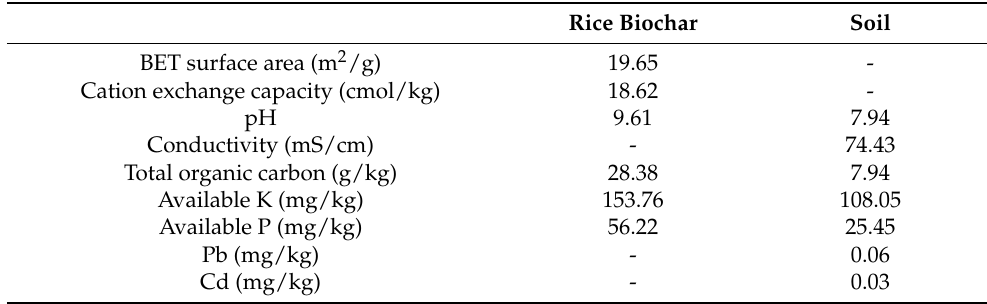
Table 1. The properties of the materials. Part of the data comes from our previous studies (-: below the detection line) (Chen et al., 2019;